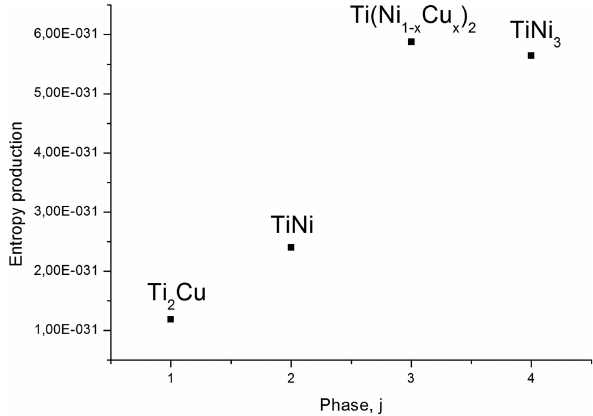
Figure 7: The graph showing calculated entropy production in sam- ple 3 for four generated